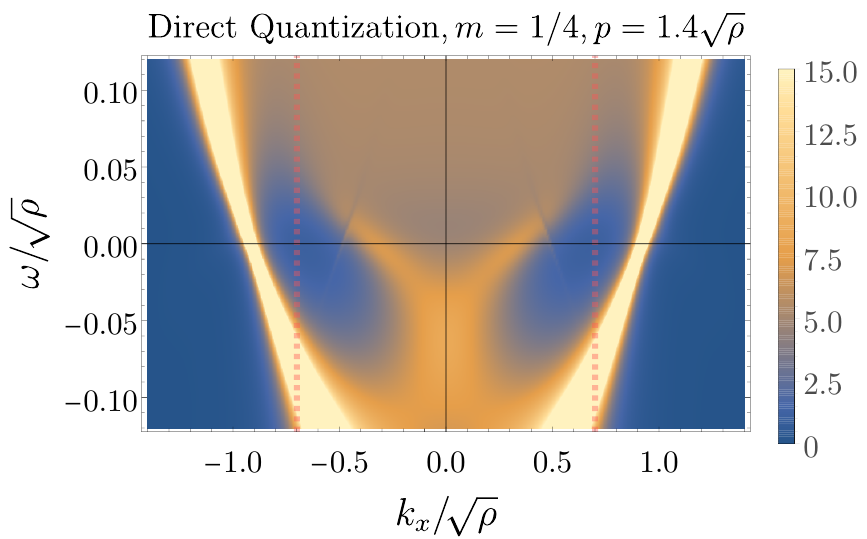
Figure 5 . The frequency resolved fermionic spectral density in the holographic model with weak unidirectional periodic potential ( (cid:21) = 0 : 1 ). The density plot shows a cut through the same data as p (cid:12)gure 4 in the k x ; ! plane, at k y = 0 : 001 (cid:26) . Around ( k x ; ! ) (cid:25) ( (cid:6) 0 : 4 ; 0 : 02), the dark lines